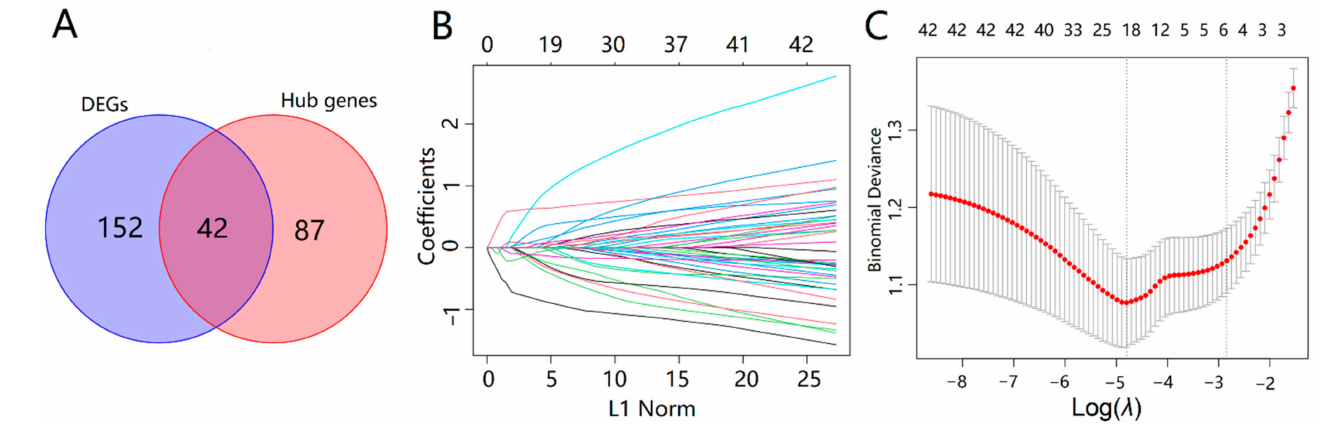
Figure 6. Screening of key genes of AD. ( A ) Venn diagram showed 42 overlapping genes in DEGs and hub genes; ( B ) LASSO coefficient profiles of 42 overlapping genes. ( C ) A coefficient profile plot was produced against the log ( λ ) sequence in the LASSO model. The optimal parameter ( λ ) was selected as the first black dotted line